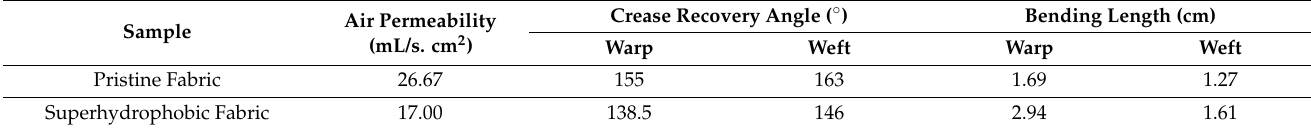
Table 2. Physical properties of pristine and superhydrophobic fabrics.